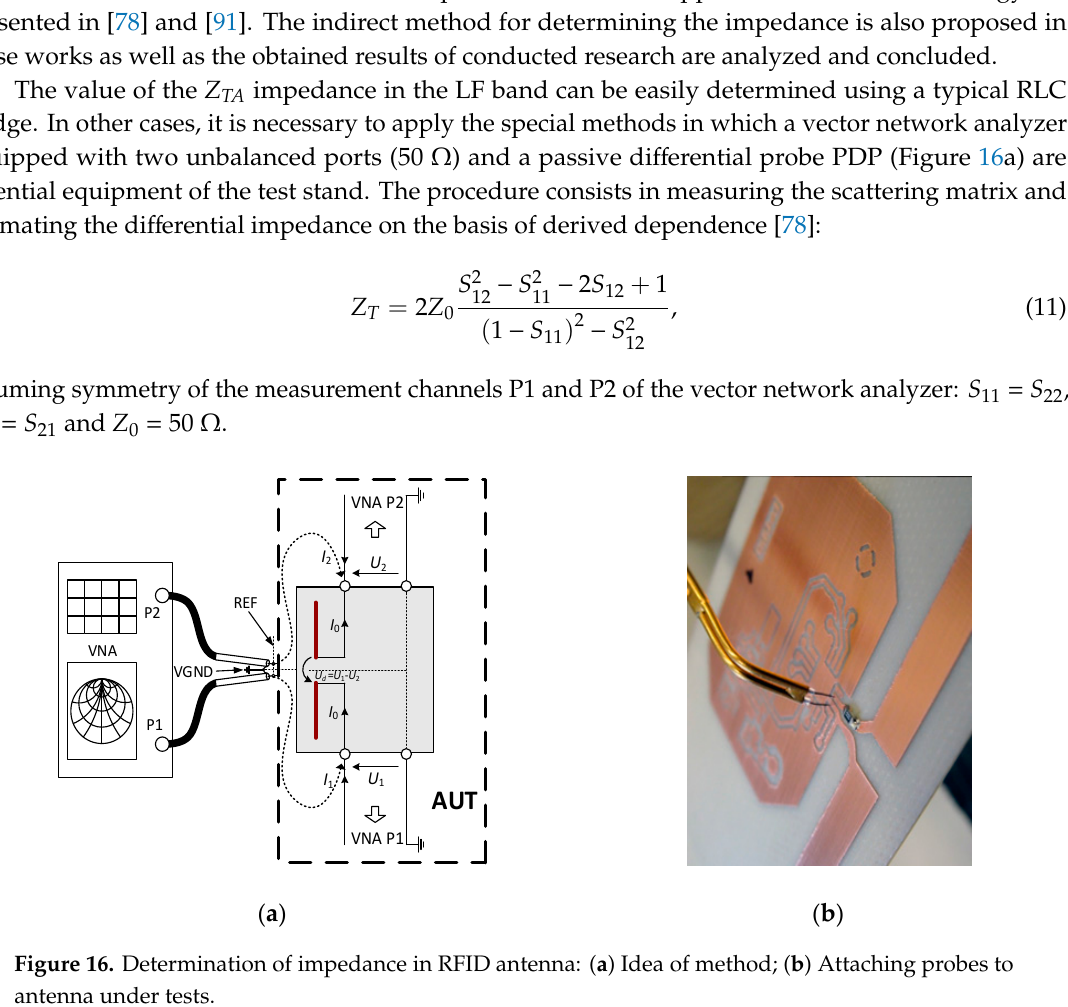
( b ) Figure 17. Equipment of measurement stand: ( a ) Handmade probes; ( b ) Professional equipment—precise probes and micromanipulator. Evaluation of the presented method dedicated to determining the impedance of RFID device components was carried out on exemplary test antennas made in the PCB technology. It was made by comparing measurements with the numerical calculations obtained in the Mentor Graphics HyperLynx 3D EM program (HL3DEM) at the antenna circuits design stage. The measurements of S parameters were performed on the laboratory stand equipped with two port vector network analyzer (VNA Keysight PNA-X N5242A), micropositioner, manufactured differential probes, test cables and calibration elements. The parameters of used substrates (thickness, relative permittivity, loss tangent), for conductive layers (thickness, resistance) and assumed pattern of coils (number of